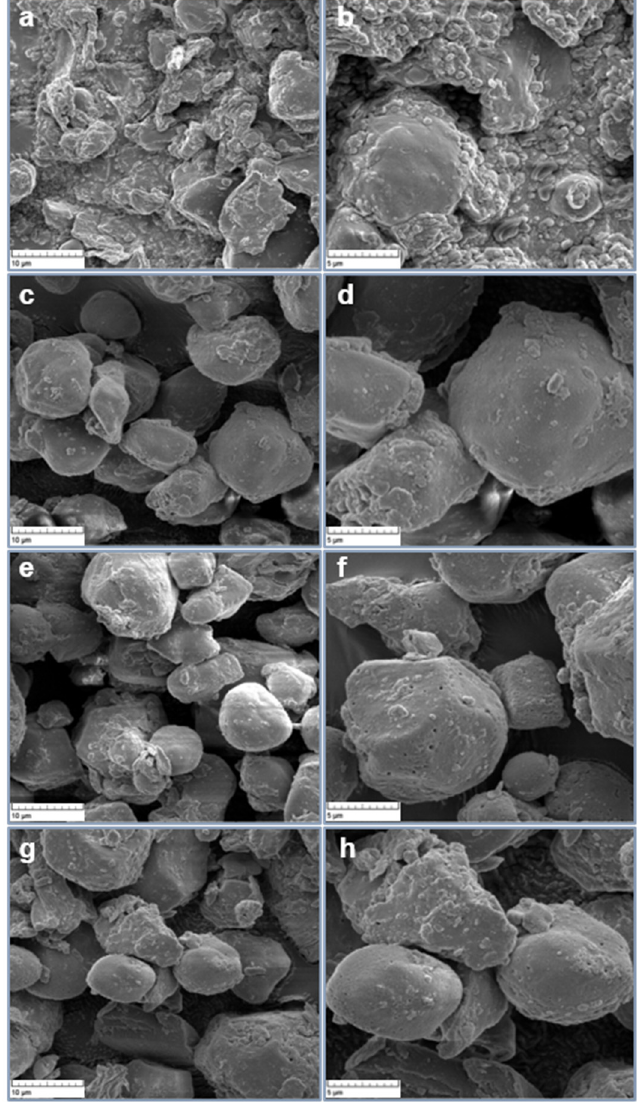
Figure 7. Scanning electron micrographs of zein protein degradation in the three types of ensiled high-moisture corn. Degradation of zein proteins in the ensiled high-moisture corn samples compared to the fresh corn samples was examined on 1 mm ground samples using a scanning electron microscope operating at 5 kV under 5000×, or 10,000× magnifications. Scanning electron micrographs of ground corn samples are as follows: fresh corn 5000× ( a ), fresh corn 10,000× ( b ), high-moisture corn ensiled with inoculant Lactiplantibacillus plantarum 5000× ( c ), high-moisture corn ensiled with inoculant Lactiplantibacillus plantarum 10,000× ( d ), high-moisture corn ensiled with lactic acid 5000× ( e ), high-moisture corn ensiled with lactic acid 10,000× ( f ), high-moisture corn ensiled without additives 5000× ( g ), and high-moisture corn ensiled without additives 10,000× ( h ). The zein protein layer in the ensiled high-moisture corn was reduced compared to the fresh corn; the highest reduction was in the Lactiplantibacillus plantarum -ensiled high-moisture corn.